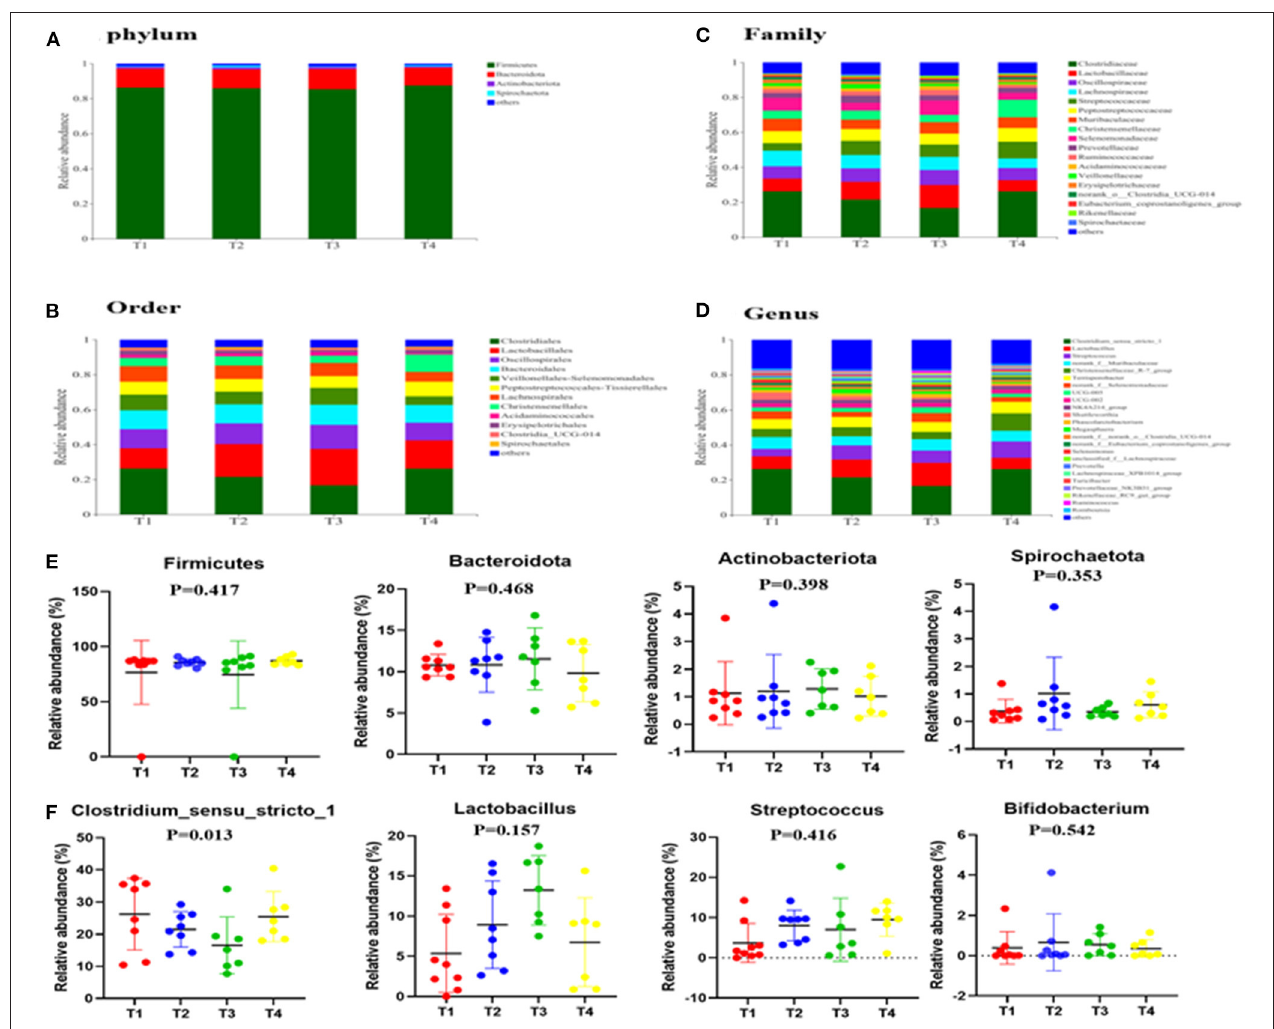
FIGURE 3 | Effects of dietary fiber on fecal microbial composition. (A,E) The relative amounts of microbiota in feces at the phylum level. (B) The relative amounts of microbiota in feces at the order level. (C) The relative amounts of microbiota in feces at the family level. (D,F) The relative amounts of microbiota in feces at the genus level. Data were expressed as the mean ±